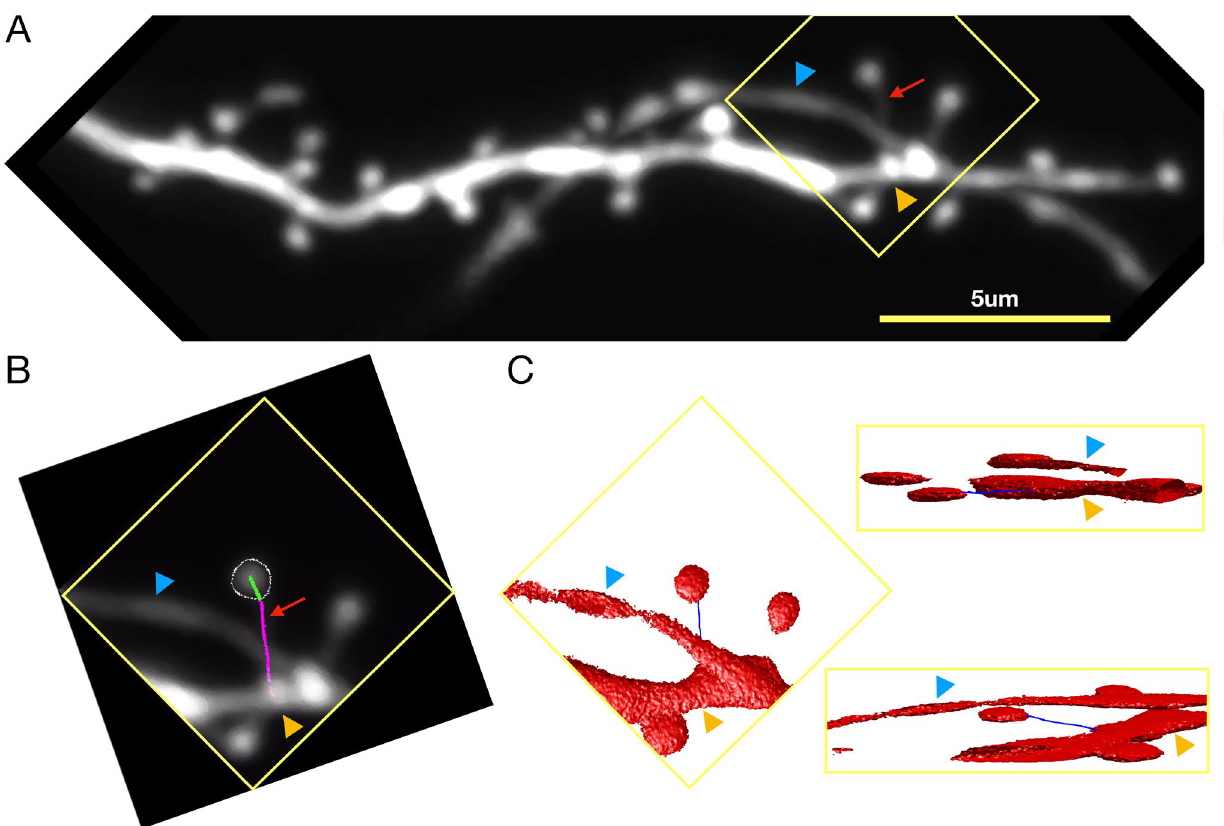
Figure 4. Finding spine neck path in 3D. ( A ) Two-photon microscopy image of a dendrite of a hippocampal CA1 pyramidal neuron in-vitro. The blue arrow indicates the nearby process. The orange arrow indicates the parent dendrite. The red arrow indicates the spine neck. Image contrast is increased to improve the visibility of the spine neck. ( B ) ROI in yellow square in (A) . The path from the parent dendrite to the spine head border is shown in magenta. The path from the spine head border to the spine head center is shown in green. ( C ) 3D rendered version of B showing the neck path from three different orientations, showing that the spine neck is correctly traced from the spine center to the dendrite but not to a nearby